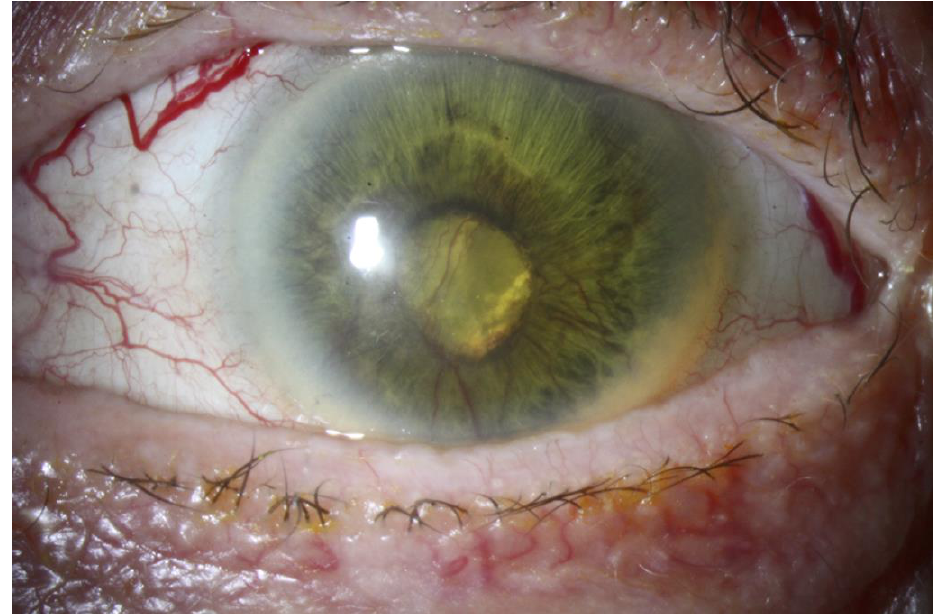
Figure 6. Neovascular glaucoma in a patient treated with proton beam therapy for a large choroidal melanoma (12 mm in height and 20 mm in diameter).